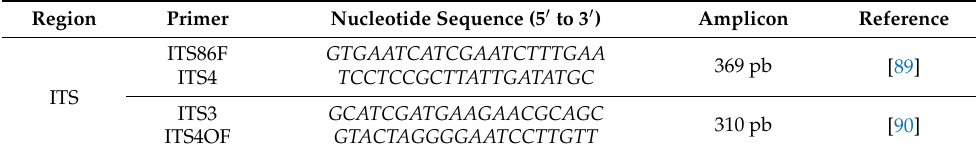
Table A4. Primers used for DNA sequencing of T . cacao samples.